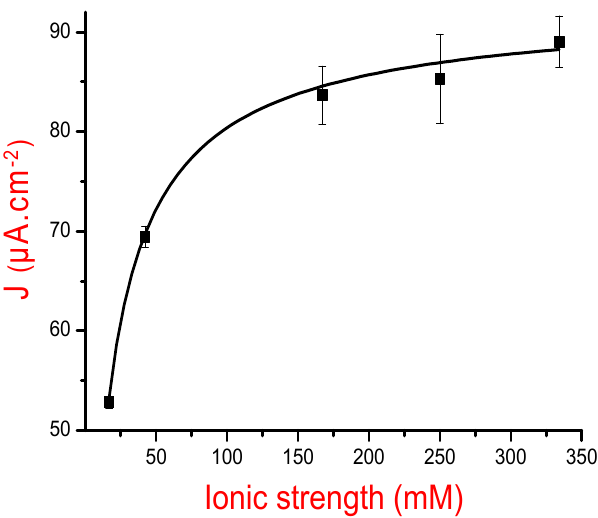
Figure 3. Variations of the current density maxima of MIPs designed at pH = 7.4 and varied ionic strengths versus the ionic strength of the BSA solution used in the MIPs’ design.